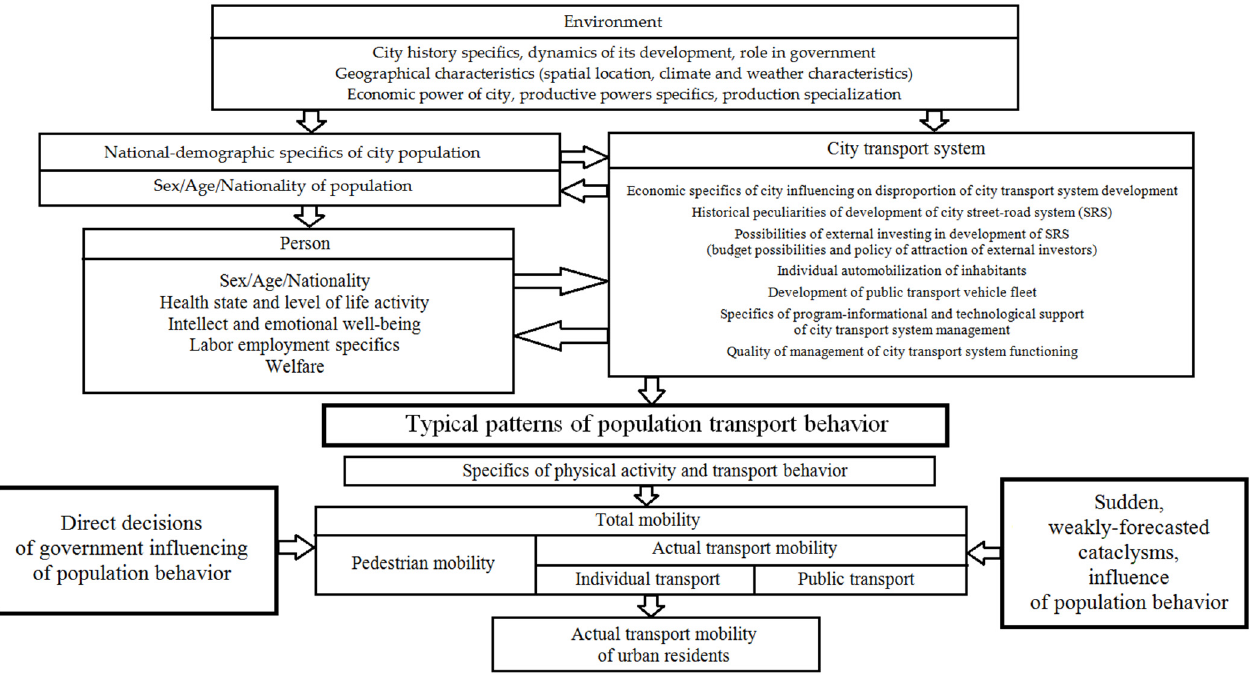
Figure 1. General scheme of formation of actual transport mobility of city